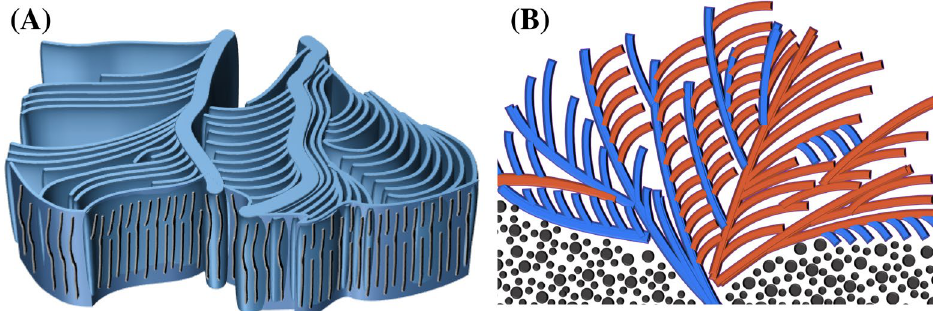
Figure 10. Schematics of lamellar assembly in the dendrite portion of sector-face PLLA spherulite: ( A ) top view and lateral view, and ( B ) optical birefringence pattern correlating with lamellar assembly and